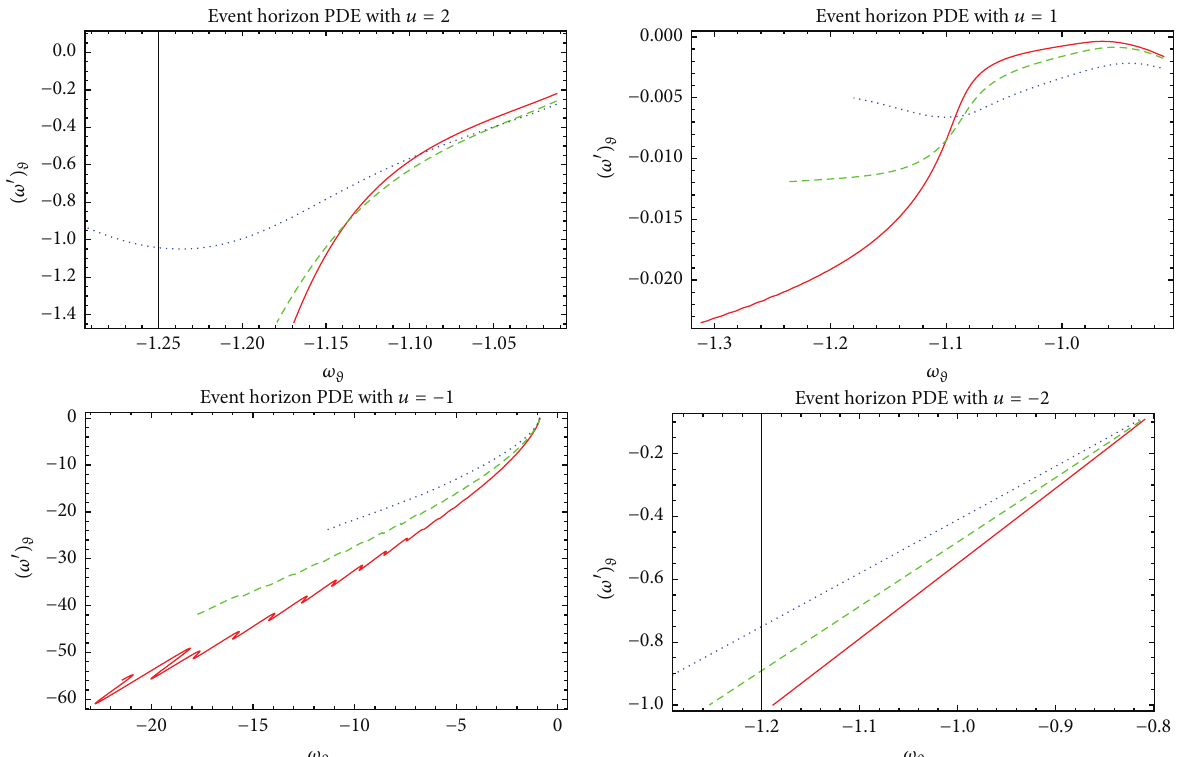
Figure 6: Plots of 𝜔 𝜗 - 𝜔 󸀠 𝜗 for event horizon PDE model in dynamical Chern-Simons gravity with 𝑢 = 2, 1, −1,−2